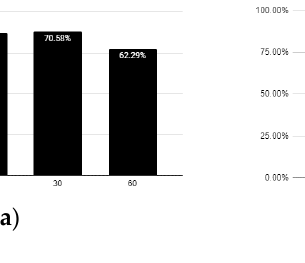
Figure 12. The accuracy of fps for each video. ( a ) Taking 30 frames as a group, the accuracy ( y -axis) of each fps ( x -axis). ( b ) Taking 60 frames as a group, the accuracy ( y -axis) of each fps ( x -axis). ( c ) Taking 90 frames as a group, the accuracy ( y -axis) of each fps ( x -axis).